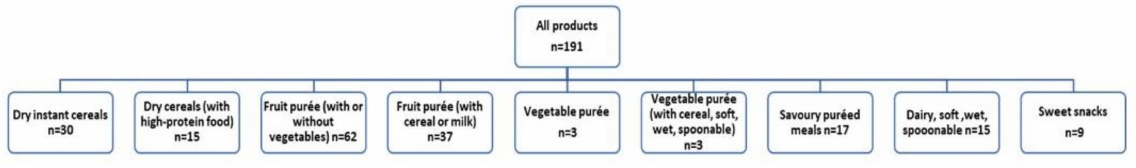
Figure 1. Sampling and Product categorization according to the